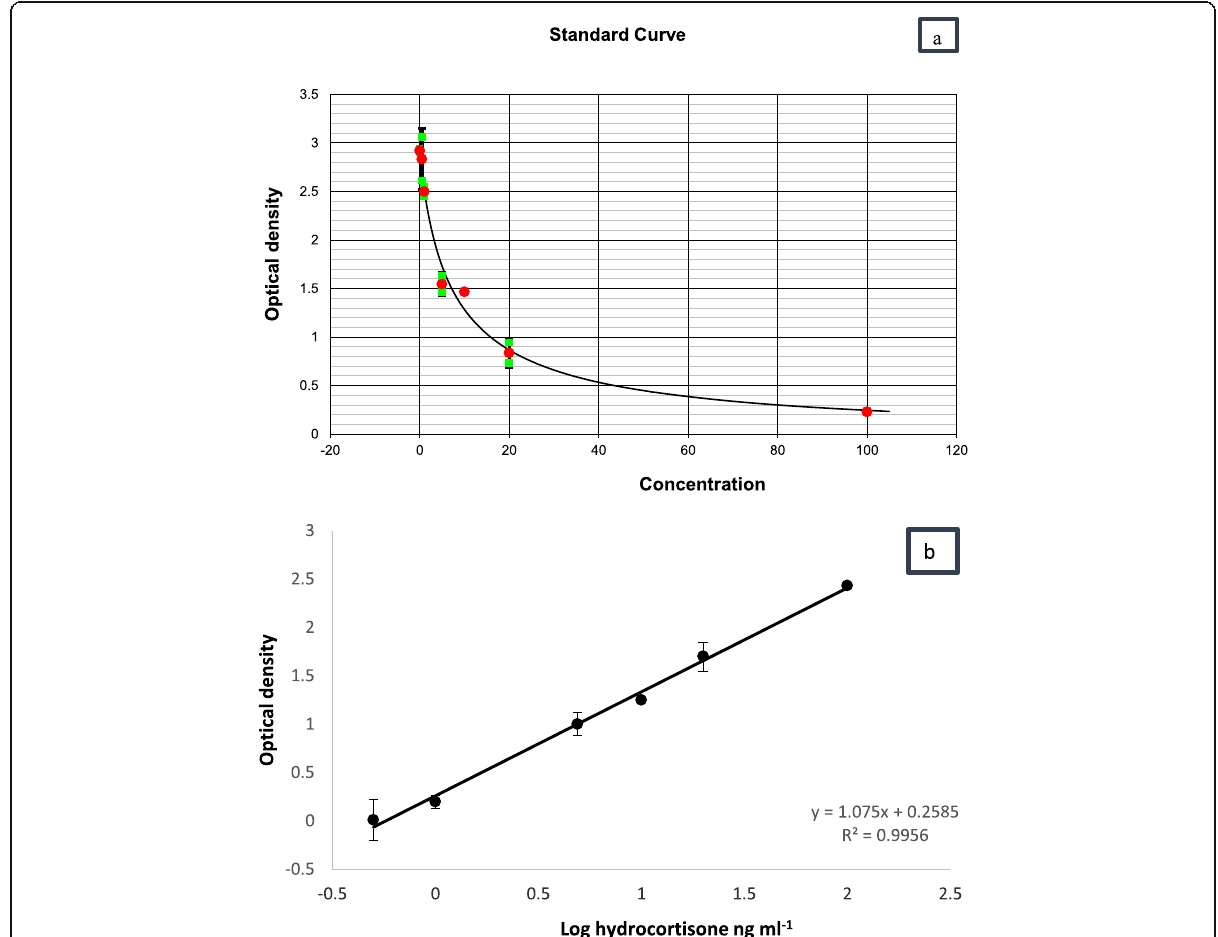
Fig. 13 Calibration curves showing a the change in the optical density with the increase of cortisol concentration where the red points indicate the cortisol concentrations, and the green points are the error bar for each concentration, b the increase in optical density with a linear trend after subtracting the blank signal from the sample